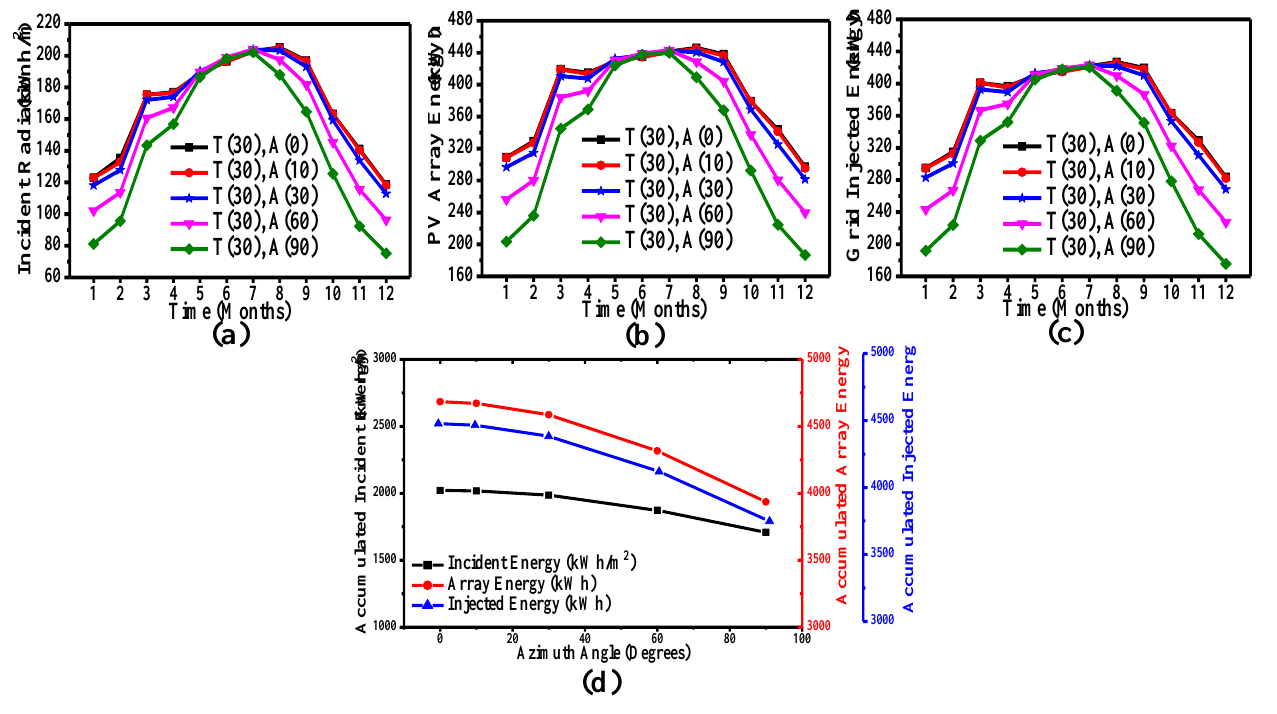
Figure 4: [T(30), A(x)] configuration: (a) incident radiation received by the module surface, (b) generated energy by the array, (c) energy injected to the grid, and (d) accumulated incident, generated, and injected energies over one